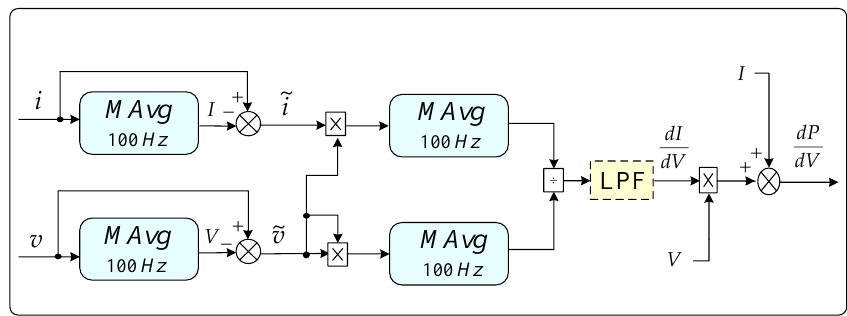
Figure 11. Block diagram of the basic RCC algorithm to estimate dP / dV in the case of existence of a single harmonic component (second harmonic) using MAvg over T /2 (100 Hz).